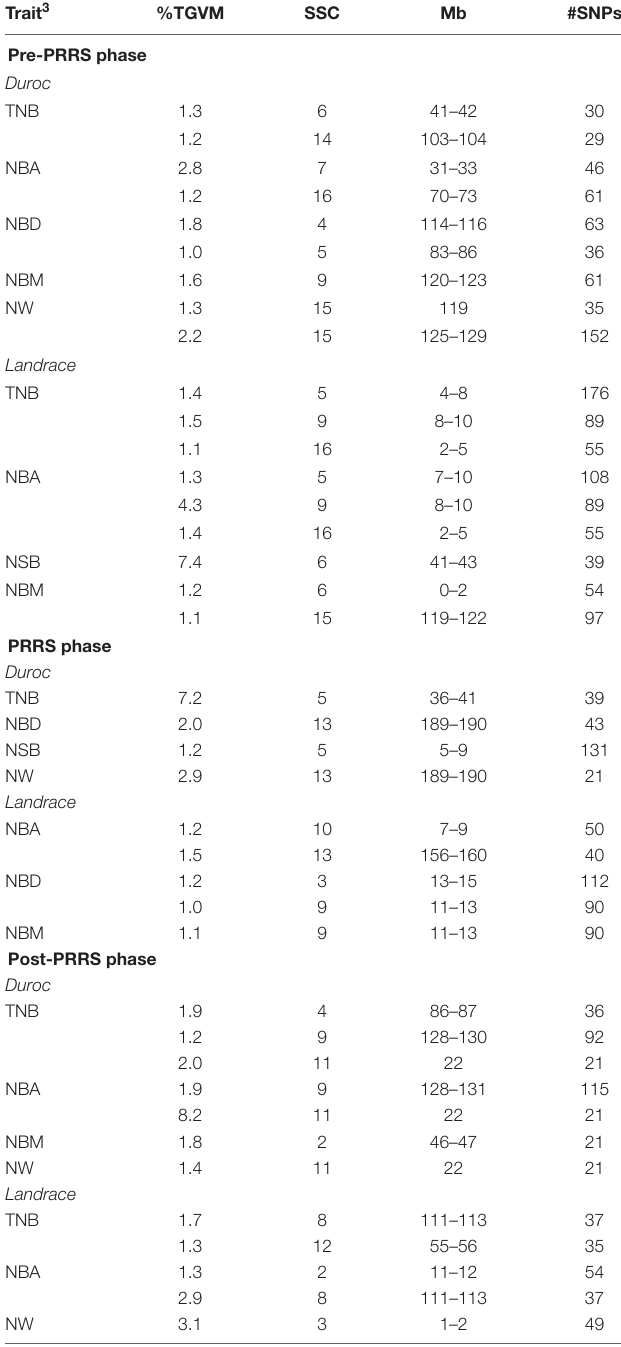
TABLE 8 | Genomic regions associated 1 with reproductive performance across PRRS 2 phases for Duroc and Landrace sows. Trait